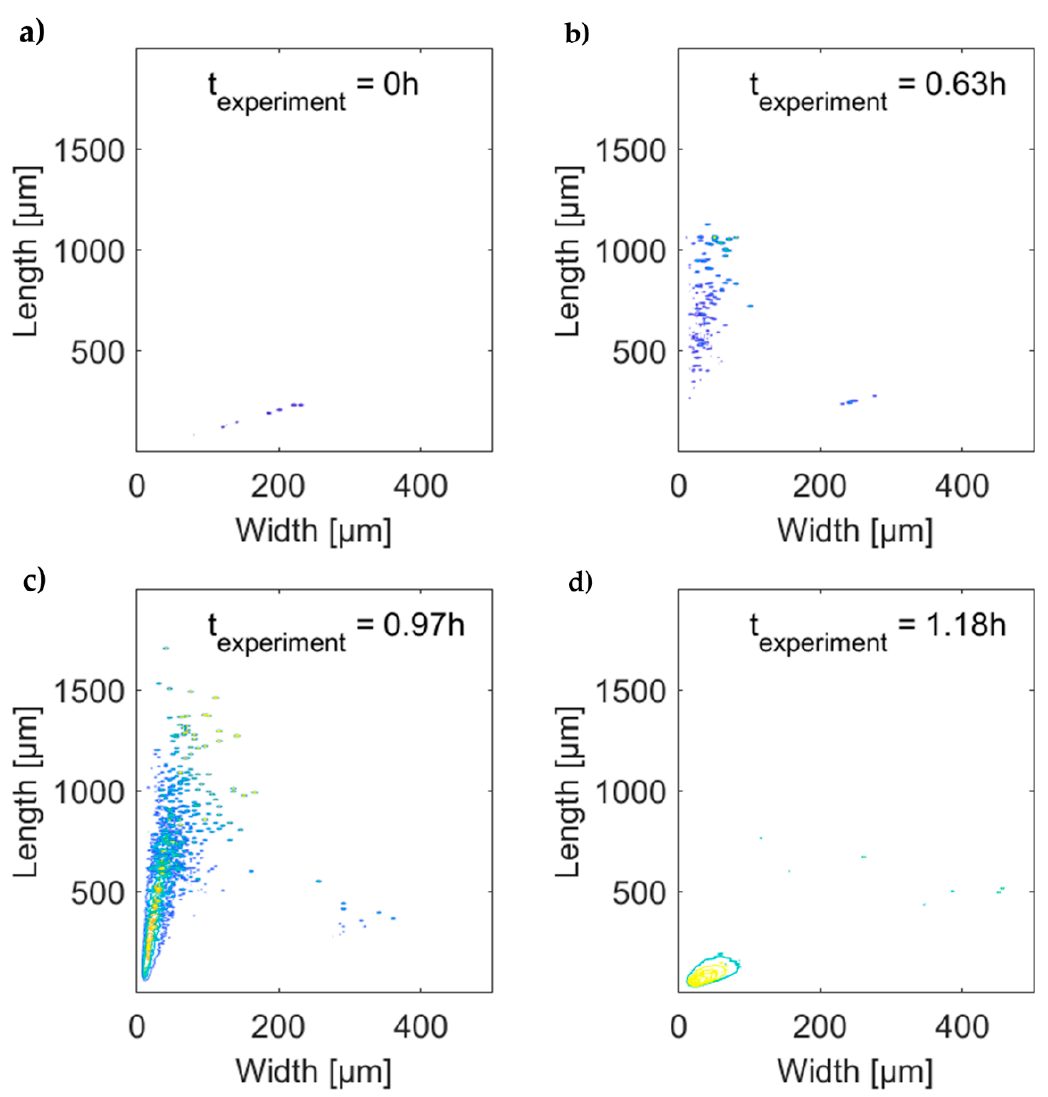
Figure 14. Length and width distributions of the needle-like crystals of thiamine hydrochloride monohydrate at different time points of Exp. 5, measured with the shadowgraphic probe. ( a ) measured crystals in the clear solution, ( b ) measurement of the first single needles, ( c ) significant number of crystals, ( d ) failed measurement as result of massive overlapping.